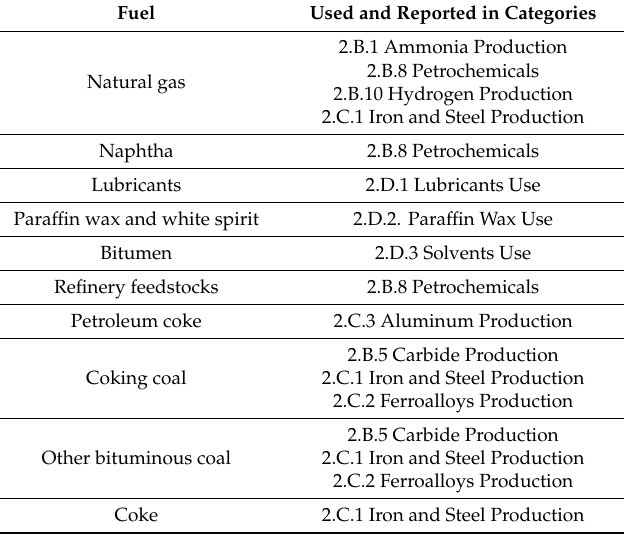
Table 4. The allocation of non-energy use of fuels in the IPPU sector in Slovakia.